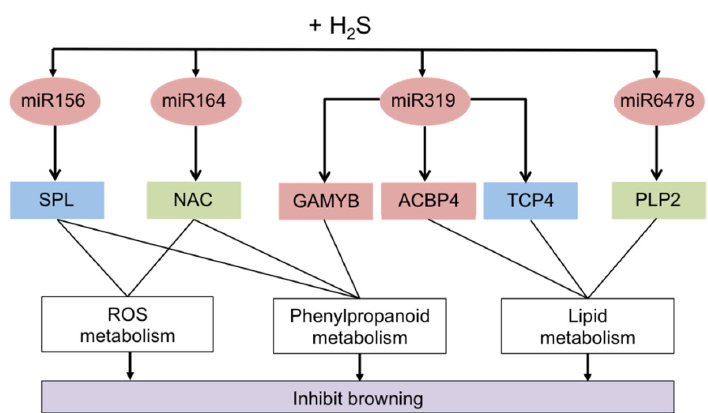
Figure 6. A proposed schematic model of miRNA ‐ mediated browning inhibition fresh ‐ cut apples induced by H 2 S. Red colour represents the DEmiRNAs or target genes that were down ‐ regulated, blue colour represents the up ‐ regulated target genes while green colour represents the target genes that either up ‐ regulated or down ‐ regulated.